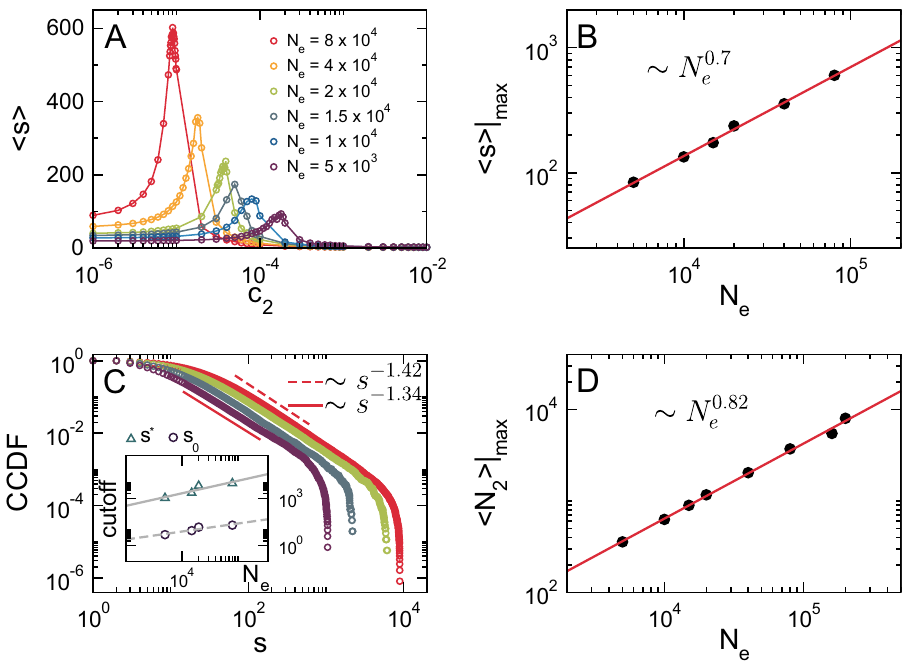
Figure 4. Finite-size scaling analysis of the AB model. ( A ) Susceptibility (cid:31) s (cid:30) as a function of c 2 for different system sizes ( c 1 = 0.01 ). (cid:31) s (cid:30) exhibits a size-dependent maximum at a pseudo–critical value c ∗ 2 ( N e ) . ( B ) Log-log plot of � s �| max as a function of N e , where the solid red line is a power-law fitting with exponent 0.7 ± 0.01 . ( C ) The CCDF of the cluster size distribution at c ∗ 2 ( N e ) for different system sizes, where dashed and solid lines 4 ) correspond to power-law fittings of the central part of the distribution with exponents − 1.42 ( N e = 8 × 10 3 ) and − 1.34 ( N e = 5 × 10 , respectively. The inset shows the scaling of small-size ( s 0 ) and large-size ( s ∗ ) cutoffs of the distribution as a function of N e , where solid and dashed lines correspond to power-law fits with exponents 0.8 ± 0.2 and 0.5 ± 0.1 , respectively. ( D ) Log-log plot of � N 2 �| max as a function of N e , where the solid red line is a power-law fitting with exponent 0.82 ± 0.01 .